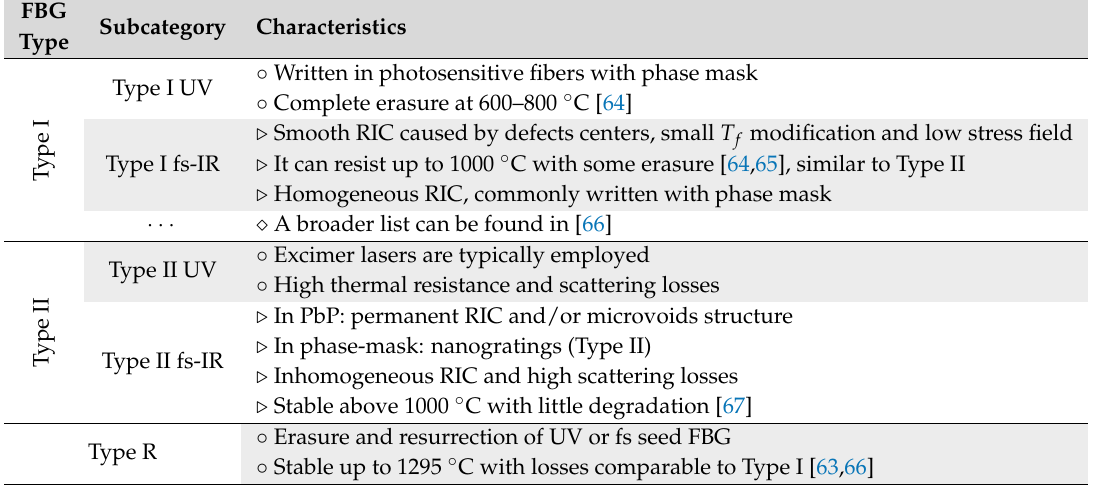
Table 1. List of different gratings and some of their